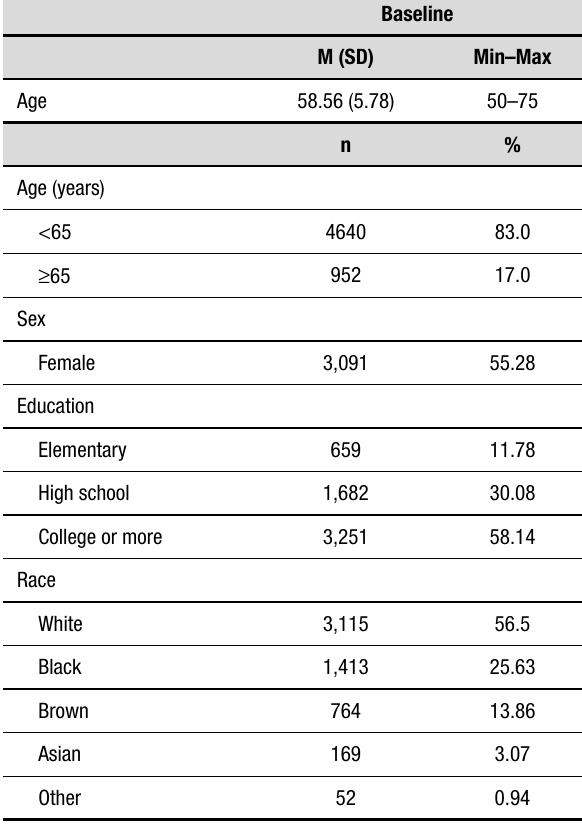
Table 1. Descriptive characteristics of the sample (n=5,592).